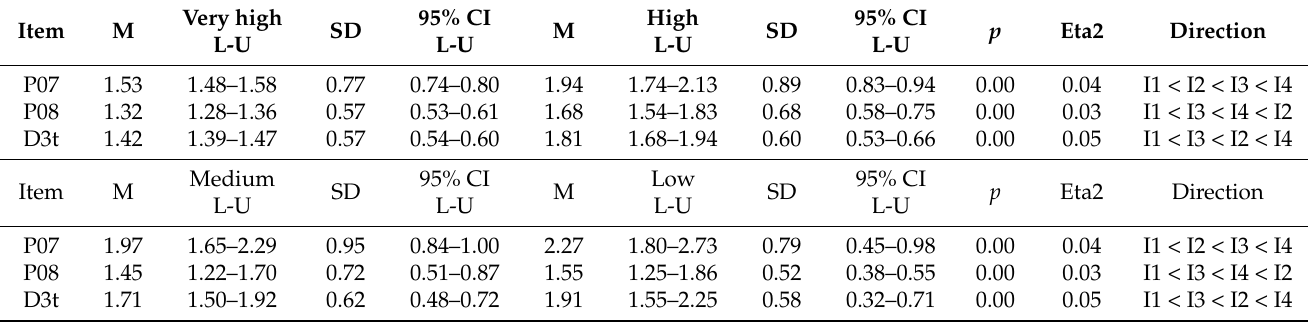
Table 10. ANOVA for independent samples by Human Development Index (HDI) for dimension D3.